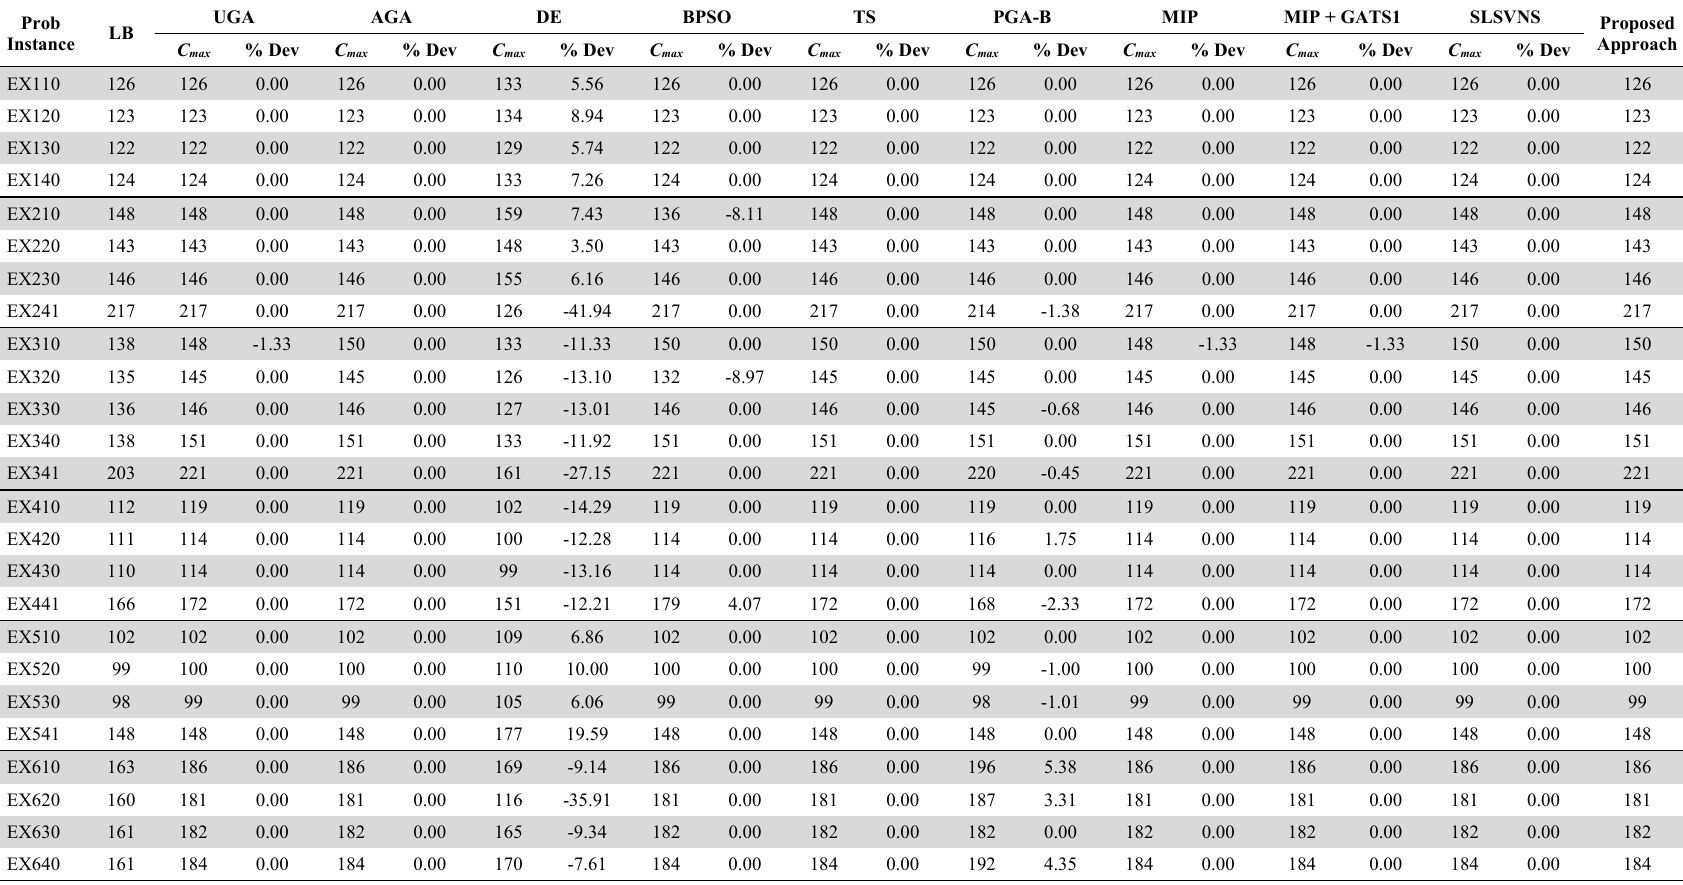
Comparison of Proposed Approach Results for Problem Set 1 for C max minimisation ( t i / p i <